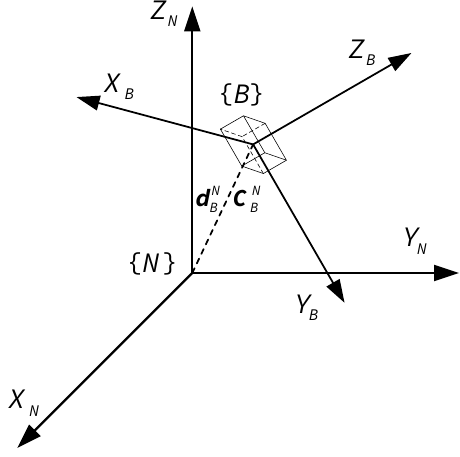
Figure 1. The transformation between the navigation frame and the body